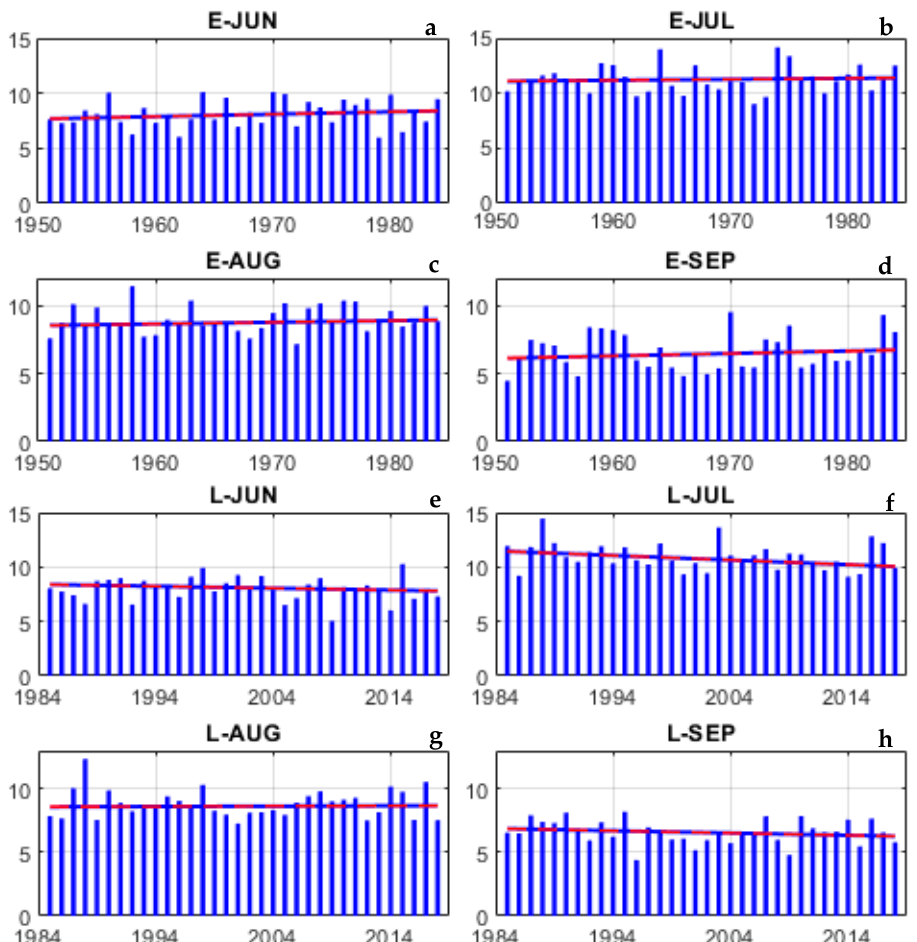
Figure 2. MK test and trends of rainfall (mm/month) over India for summer months for E-Period ( a ) June, ( b ) July, ( c ) August, ( d ) September, and for L-Period (L) ( e ) June, ( f ) July, ( g ) August, ( h ) September. On each panel prefix, “E” means, data considered from 1951 to 1984, while prefix “L” means, data consideration from 1985 to 2018 in this figure and the following figures. The blue line shows the trend, while the red dotted lines show confidence at a 95% significance level here. The same nomenclature is followed in all the